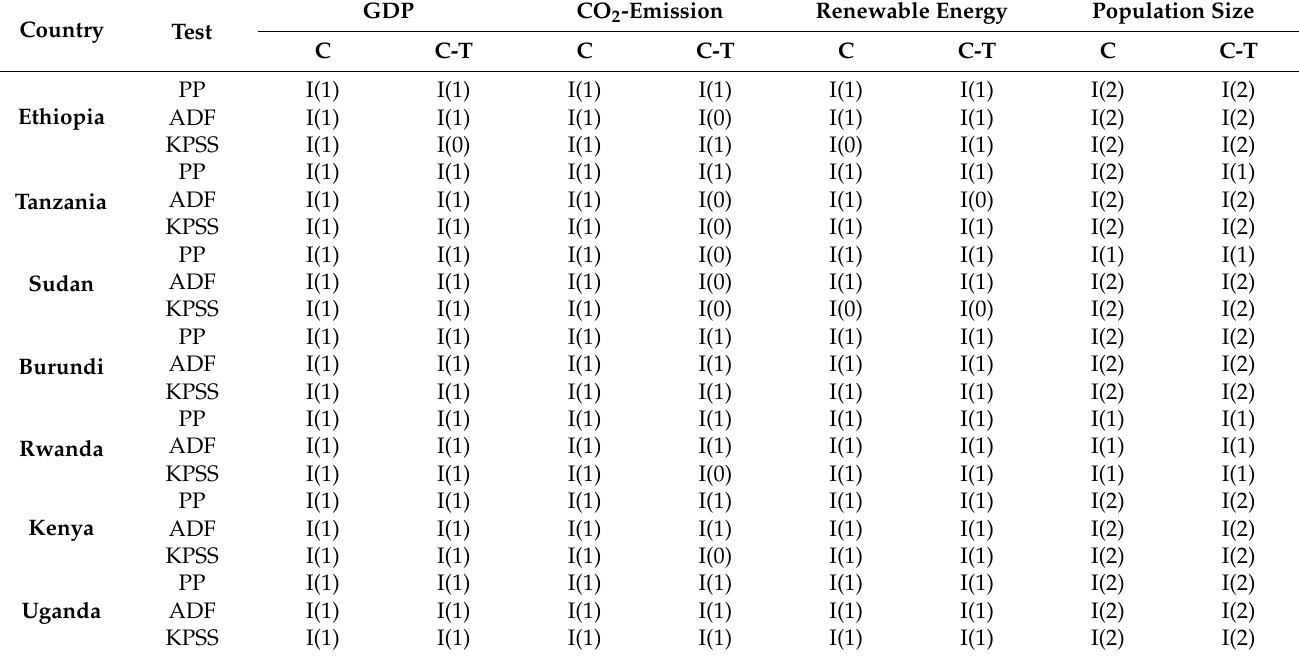
Table 5. Unit root test results for individual